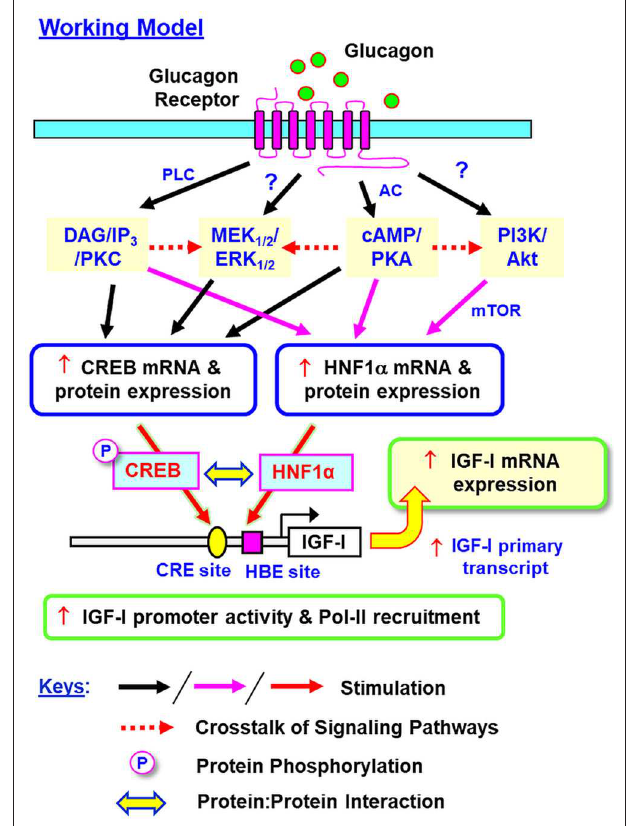
FIGURE 15 | Working model for glucagon-induced IGF-I expression in the carp liver. In carp hepatocytes, glucagon can induce IGF-I gene expression via activation of the cAMP/PKA, PLC/IP 3 /PKC, MEK 1 / 2 /ERK 1 / 2 , and PI3K/Akt pathways. During the process, parallel rises in HNF1 α and CREB expression (at both mRNA and protein levels) and protein phosphorylation of CREB can also be noted. Apparently, the cAMP/PKA and PLC/IP 3 /PKC pathways together with PKA crosstalk with the PI3K/Akt cascades are involved in glucagon-induced HNF1 α expression. Interestingly, the corresponding responses for CREB are mediated by cAMP/PKA and PLC/IP 3 /PKC pathways together with the functional crosstalk of PKA and PKC with the MEK 1 / 2 /ERK 1 / 2 cascade. Protein:protein interaction of HNF1 α with phosphorylated CREB and transactivation via the CRE and HBE sites within the proximal promoter of IGF-I gene can trigger Pol-II recruitment and IGF-I gene transcription to initiate the subsequent production of IGF-I primary transcript and mature RNA. In this model, whether a direct induction of MEK 1 / 2 /ERK 1 / 2 and PI3K/Akt cascades can also occur with glucagon receptor activation is still unclear and the possibility of “receptor coupling” via G βγ cannot be